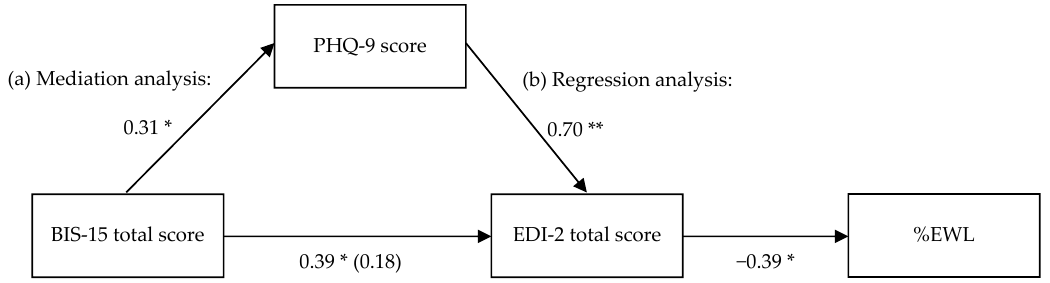
Figure 2. Mediation and regression analyses concerning the relationship between impulsivity, depression, pathological eating behavior, and weight loss: (a) Standardized regression coefficients for the relationship between the BIS-15 total score, the PHQ-9 score, and the EDI-2 total score. The standardized regression coefficient between the BIS-15 total score and the EDI-2 total score, controlling for the PHQ-9 score, is in parantheses. n = 50; (b) Standardized regression coefficient of the relationship between the EDI-2 total score and %EWL. n = 53. * p < 0.05, ** p < 0.001,